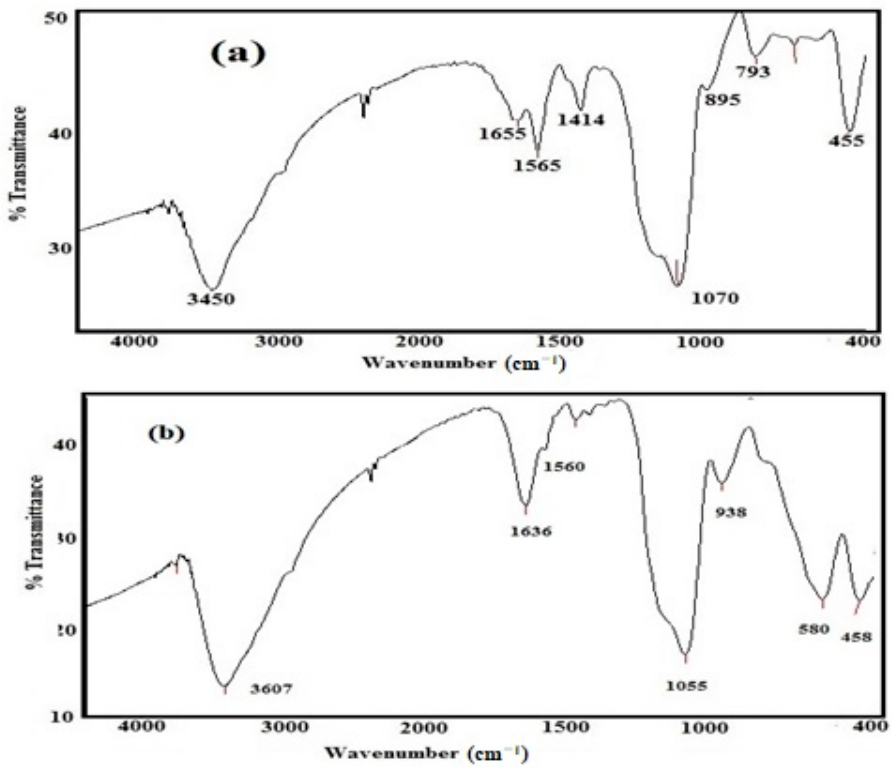
Figure 2. FT-IR spectra of ( a ) Si-IL and ( b ) Fe 3 O 4 -Si-IL.